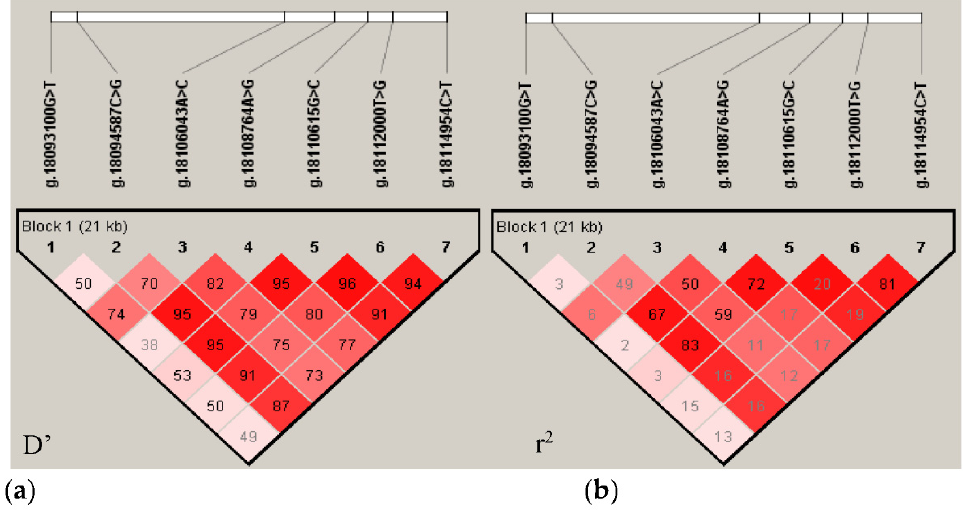
Figure 2. Haplotype constructed by seven SNVs of the NR6A1 gene. Note: the linkage disequilibrium (LD) plot within 7 SNVs of the NR6A1 gene was computed by Haploview 4.2 software. The color of each square from light to dark (white to red) indicates the degree of LD from low to high. ( a ) the linkage disequilibrium index of D’, ( b ) the linkage disequilibrium index of r 2 .